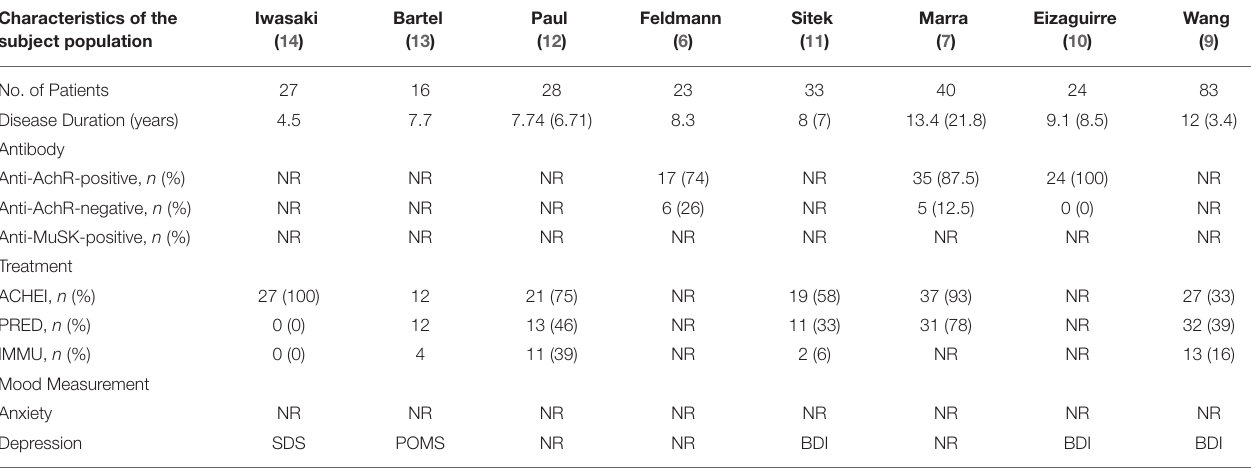
TABLE 2 | The pathophysiological and psychological characteristics of the patients with myasthenia gravis (MG). Characteristics of the subject